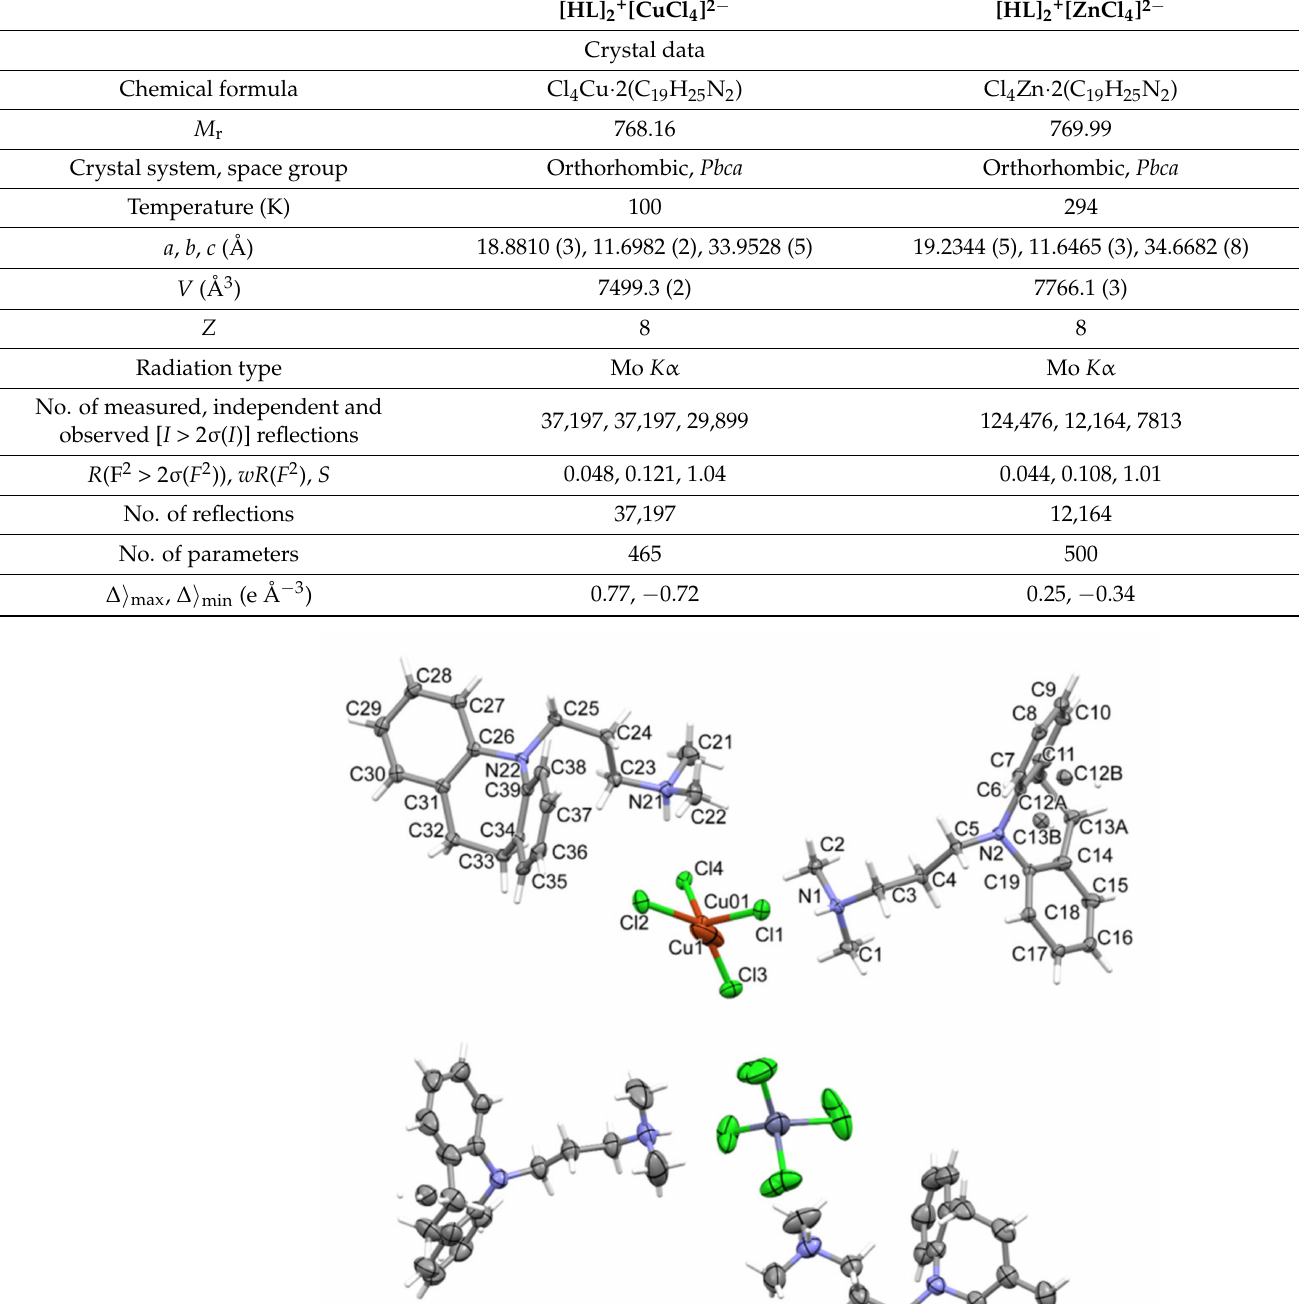
Table 1. Crystal data for [HL] 2+ [CuCl 4 ] 2 − and [HL] 2+ [ZnCl 4 ] 2 − compounds.